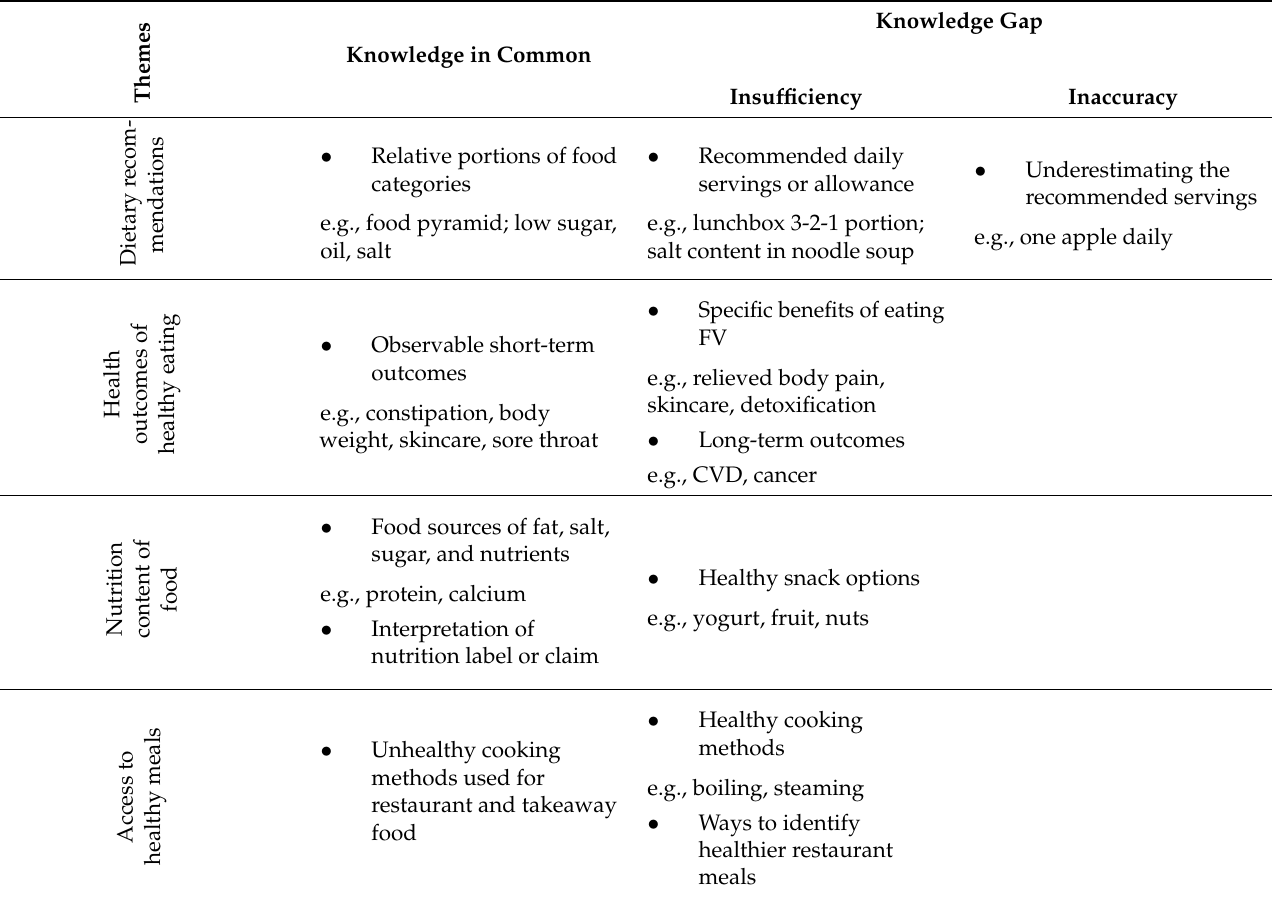
Table 3. Summary of themes in adolescent knowledge of healthy